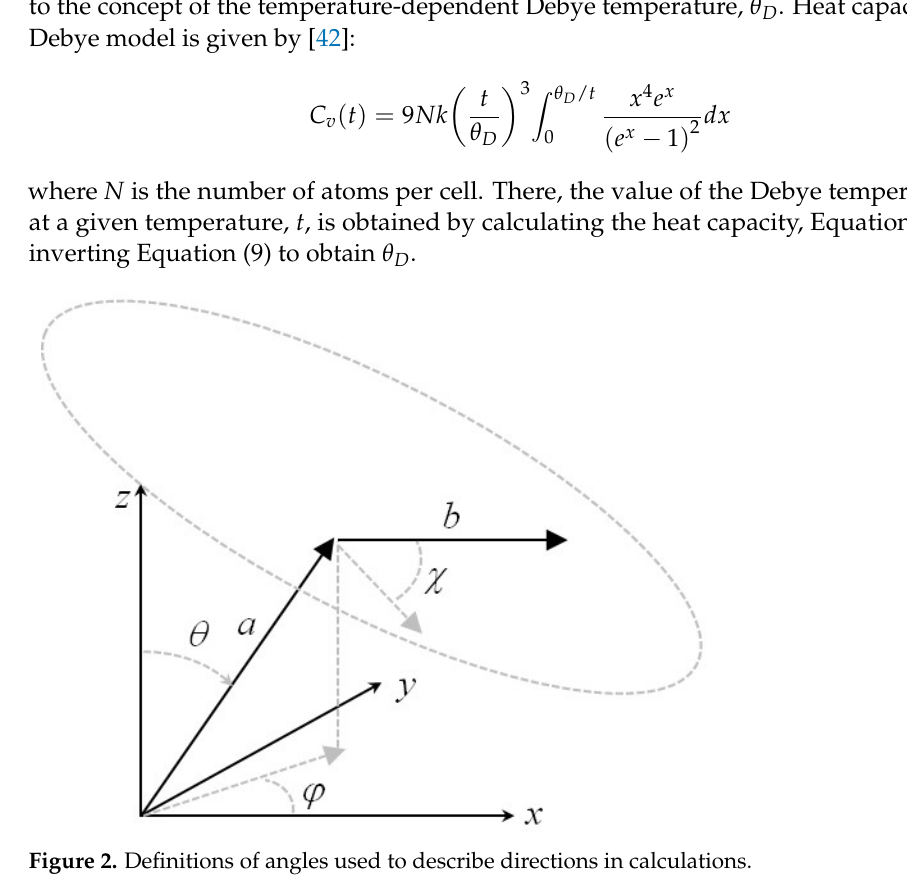
Figure 2. Definitions of angles used to describe directions in calculations.